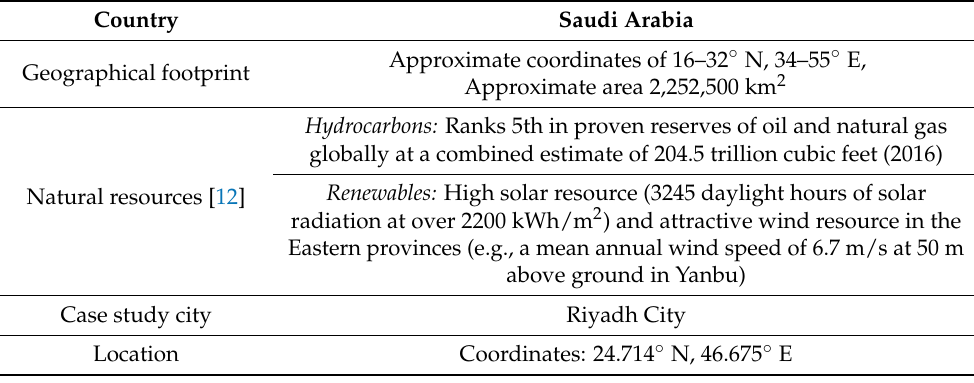
Table 1. Fundamental information about the case study country [12,13]. Country